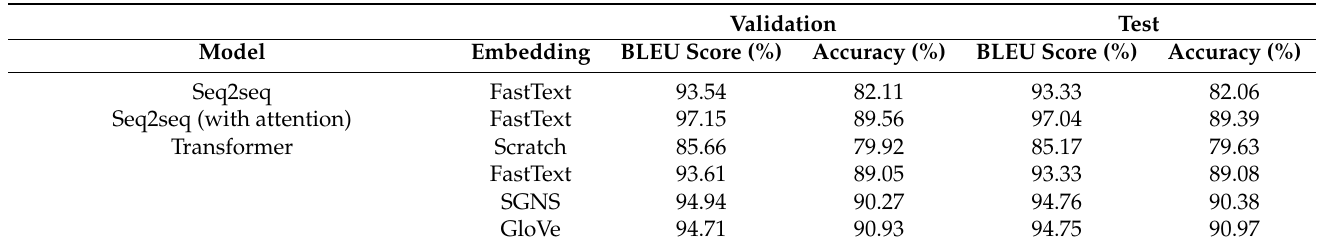
Table 7. Quantitative performance results obtained using the validation and test datasets for each model and embedding